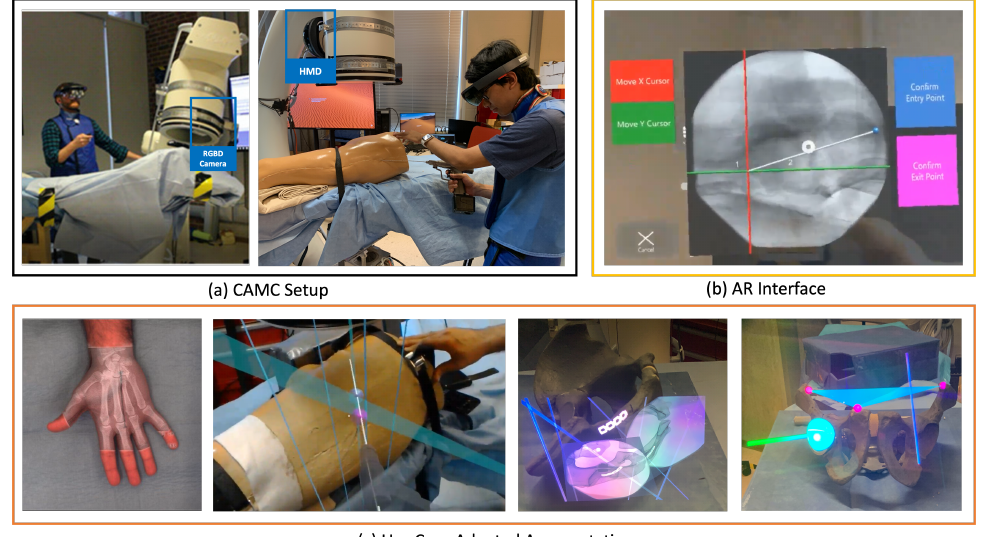
Figure 6. CAMC aims to reduce the need for ionizing radiations and to provide spatially aware, intuitive visualization of joint optical and fluoroscopic data. ( a ) Calibration of the C-arm with the patient and the technician and surgeon’s HMD enables efficient surgical procedures in a collaborative ecosystem. ( b ) Advanced AR interface aids in better planning trajectories on the X-ray acquisitions. ( c ) The adaptive UI and augmentations in intra-operative planning and execution support various image-guided